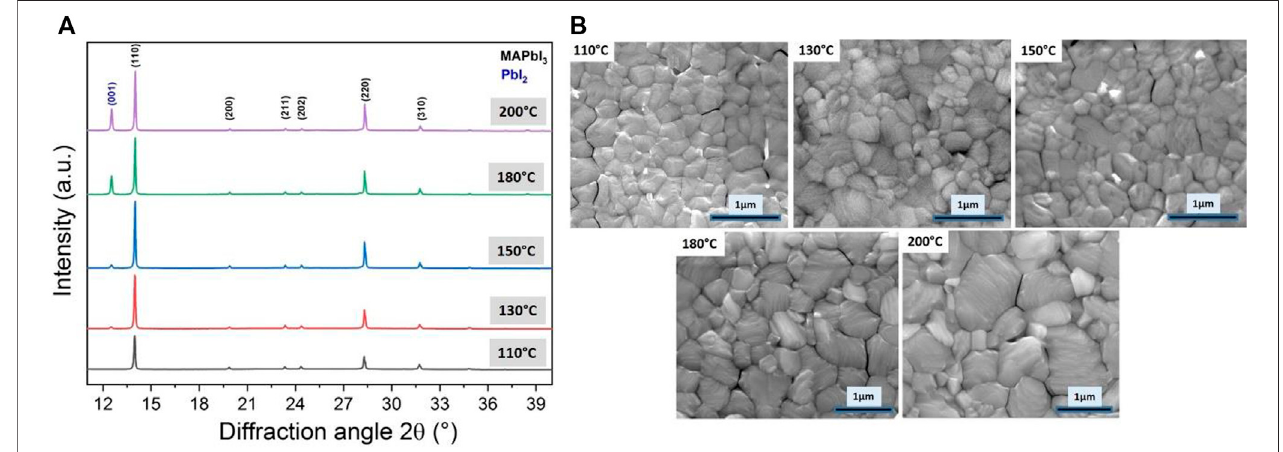
FIGURE 3 | (A) Evolution of the X-ray diffractograms as a function of the annealing temperature between 110 ° C and 200 ° C for 30 min in Ar- fi lled glovebox and (B) corresponding top-view SEM images of the resulting fi lm.